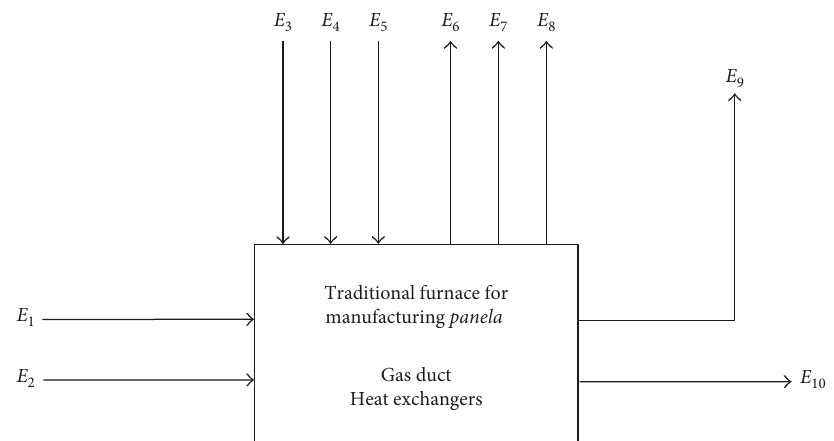
1 : bagasse, E 2 : air, E 3 : sugarcane juice, E 4 : solid